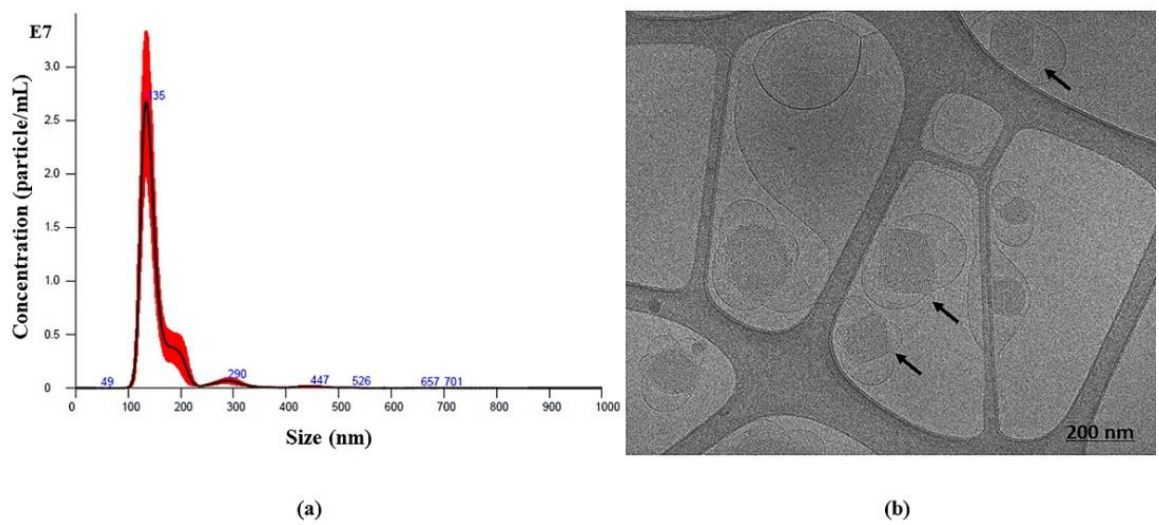
Figure 2. ( a ) Nanoparticle tracking analysis of GaPP-LCNP presented from five consecutive 60 s runs. The graph indicates monodispersity of nanoparticles with mode value of 135 nm. ( b ) Cryo-TEM image of GaPP-LCNP showing cubic shaped lyotropic liquid crystals (cubosomes) with particle average diameter of 150 nm.